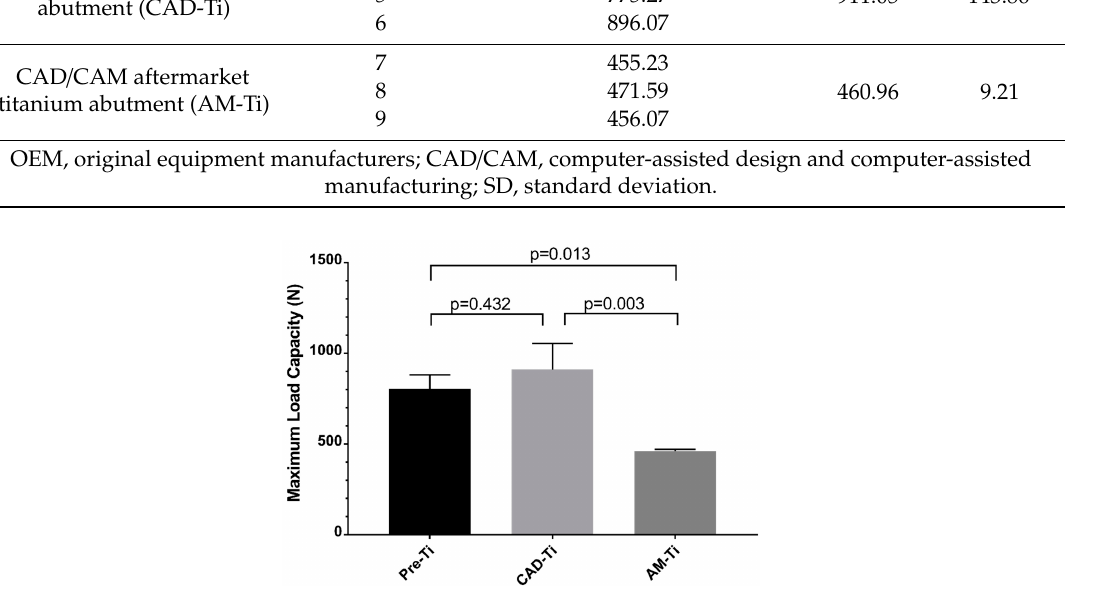
Figure 5. Mode of failure in aftermarket titanium abutment: ( a ) deformation of hexagon portion of the abutment; ( b ) fracture line over the abutment (arrow); ( c ) deformation of the implant with retentive screw fracture, the fracture surface of retentive screw was at the level of the implant platform. 4. Discussion In the present study, both OEM titanium abutments showed significantly higher maximum load capacity than the aftermarket titanium abutments. The null hypothesis, that all titanium abutments would have similar load-to-fracture values, was rejected. The maximum load capacity of the three different titanium abutments were all higher than the physiological incisive force in the anterior region reported in studies (90–370 N) [21]. However, in some cases, such as trauma-related dental injuries or patients with parafunction habits, (e.g., bruxism, clenching, etc.), the incisive force could be much higher than the physiological range [22]. Waltimo et al. [23] reported that in men with severe dental attrition, the maximum incisive force in the anterior region may reach 569 N or higher. If excessive force causes catastrophic damage to the implant–abutment complex, physicians may need